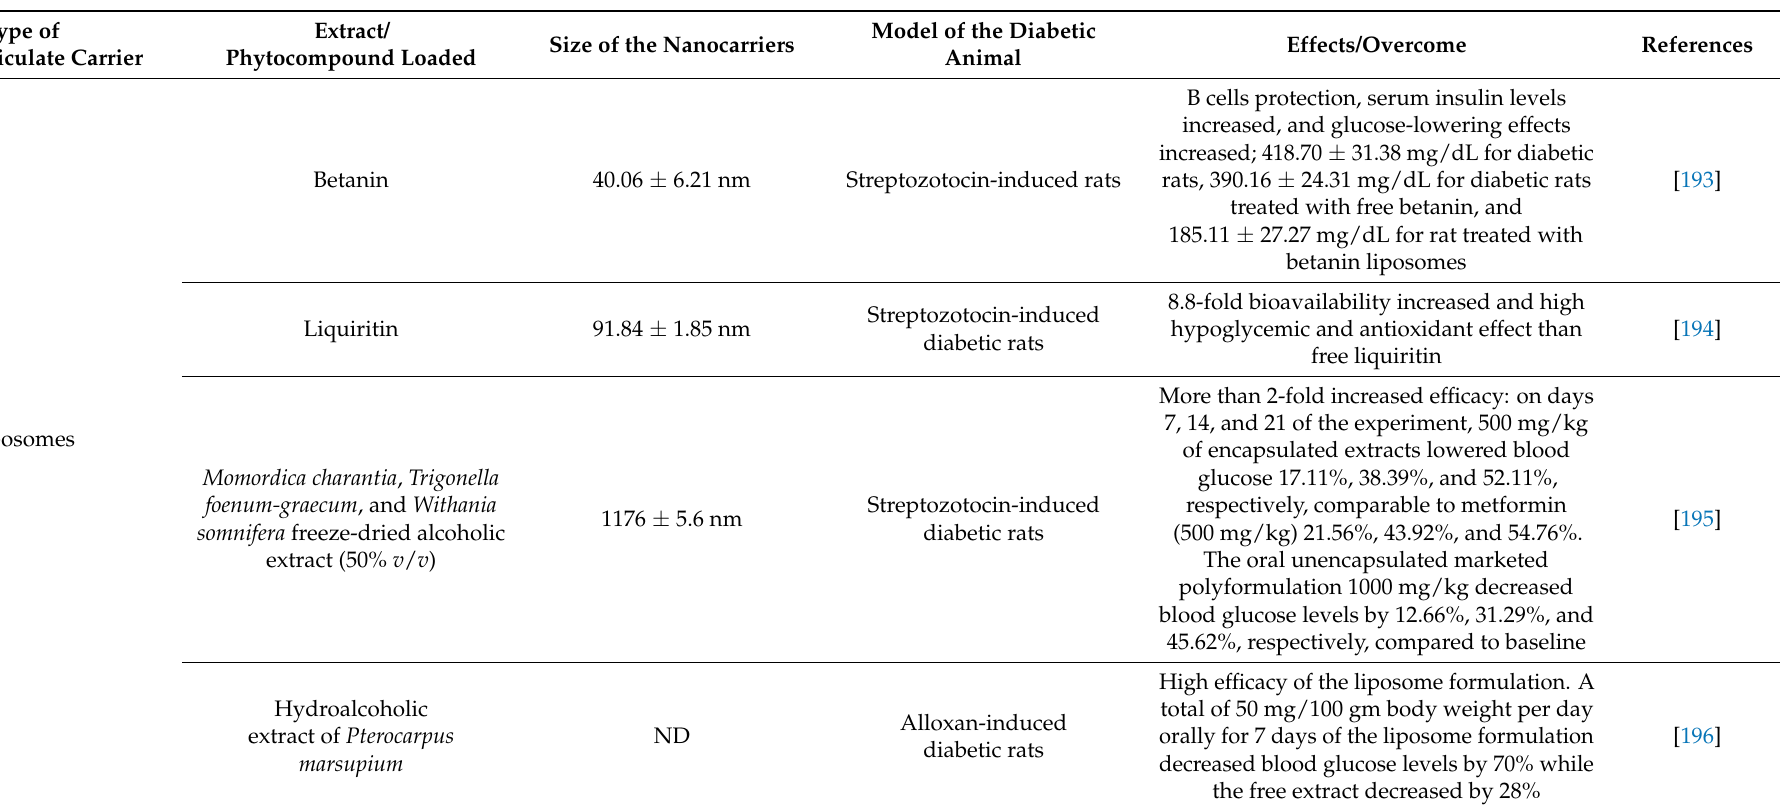
Table 1. Summary of the in vivo effects of current plant-based antidiabetic drugs or phytochemicals loaded in lipid-based nanoparticle carriers compared to unloaded